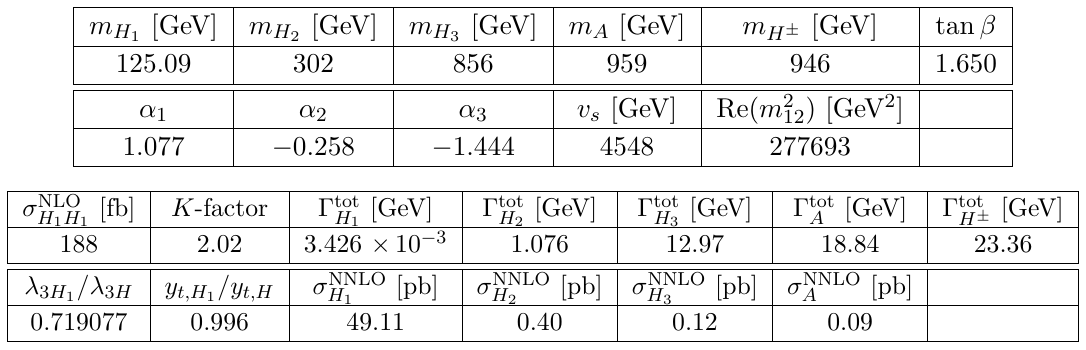
Table 15 . BP8 Upper: N2HDM-II input parameters. Lower: additional double and single Higgs production related